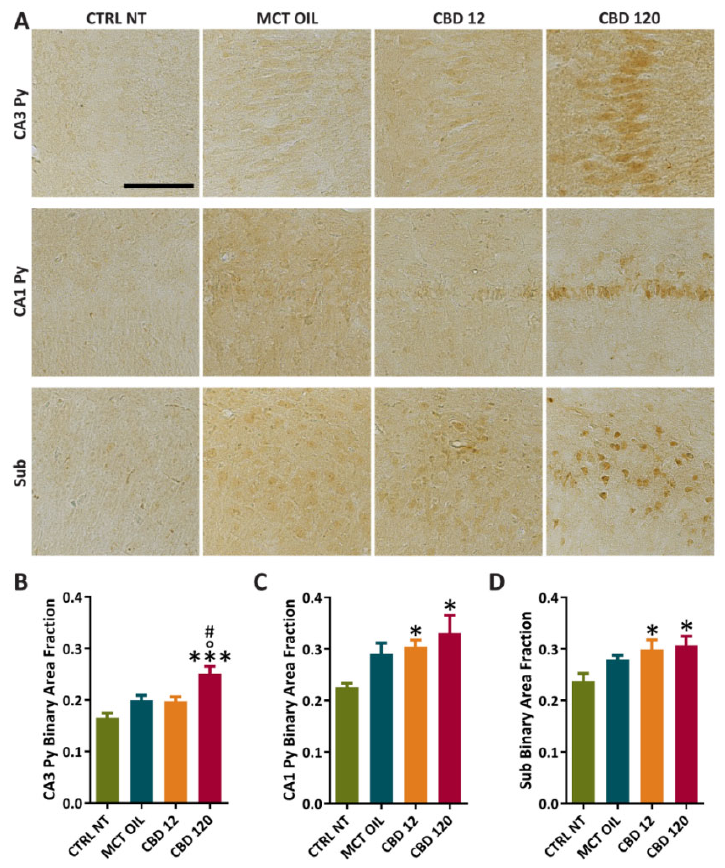
Figure 5. PPAR γ immunoreactivity in hippocampal regions of controls and rats treated with cannabidiol (CBD) or with medium ‐ chain triglyceride (MCT) oil. Non ‐ treated controls (CTRL NT, n = 6) and epileptic animals ( A ) treated with CBD at high dose (CBD 120, n = 6), CBD at low dose (CBD 12, n = 6), or MCT oil (MCT OIL, n = 6) were used to determine the levels of PPAR γ in CA3 Py ( B ), CA1 Py ( C ), and Sub ( D ). * p < 0.05, *** p < 0.001, CBD 12 or CBD120 vs. CTRL NT; ° p < 0.05, CBD 120 vs. MCT OIL; # p < 0.05, CBD 120 vs. CBD 12; Holm ‐ Šidák test. CTRL NT, non ‐ treated control; CBD, cannabidiol. CA3 Py, Stratum pyramidalis of Cornu Ammonis 3 ; CA1 Py, Stratum pyramidalis of